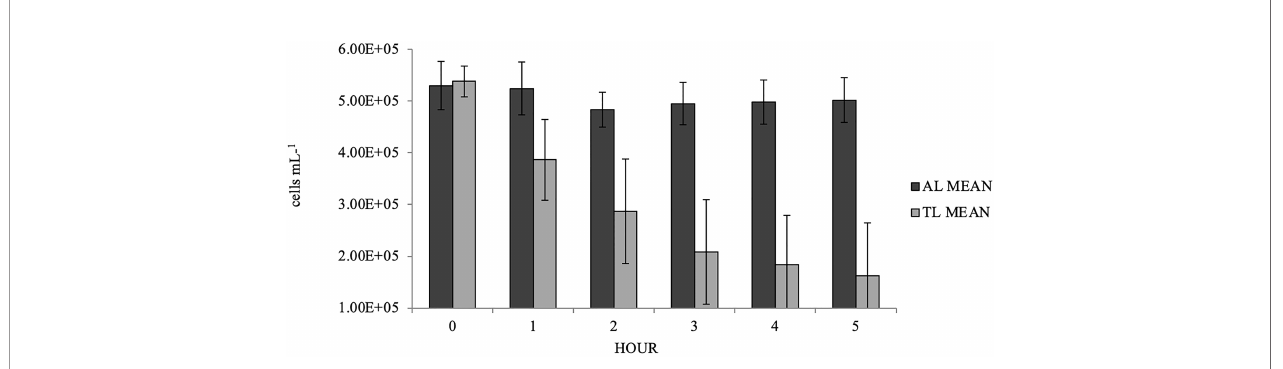
FIGURE 2 | Mean (± s.d., n=10) hourly microalgae cell densities for Styela plicata exposed to Aureoumbra lagunensis (AL) or Tisochrysis lutea (TL,